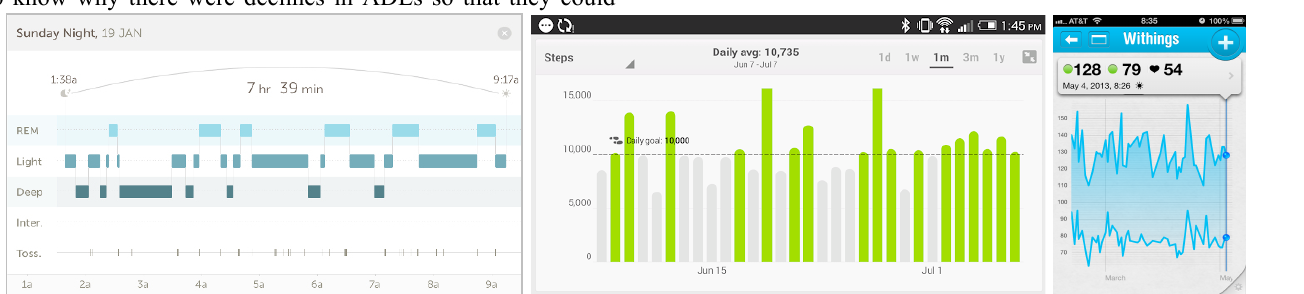
Example visualisations shown to participants. Horizontal bar chart to display sleep activity (1a; www.mybasis.com), column chart highlighting achieved goals (1b; www.fitbit.com), and line graph displaying blood pressure readings (1c;